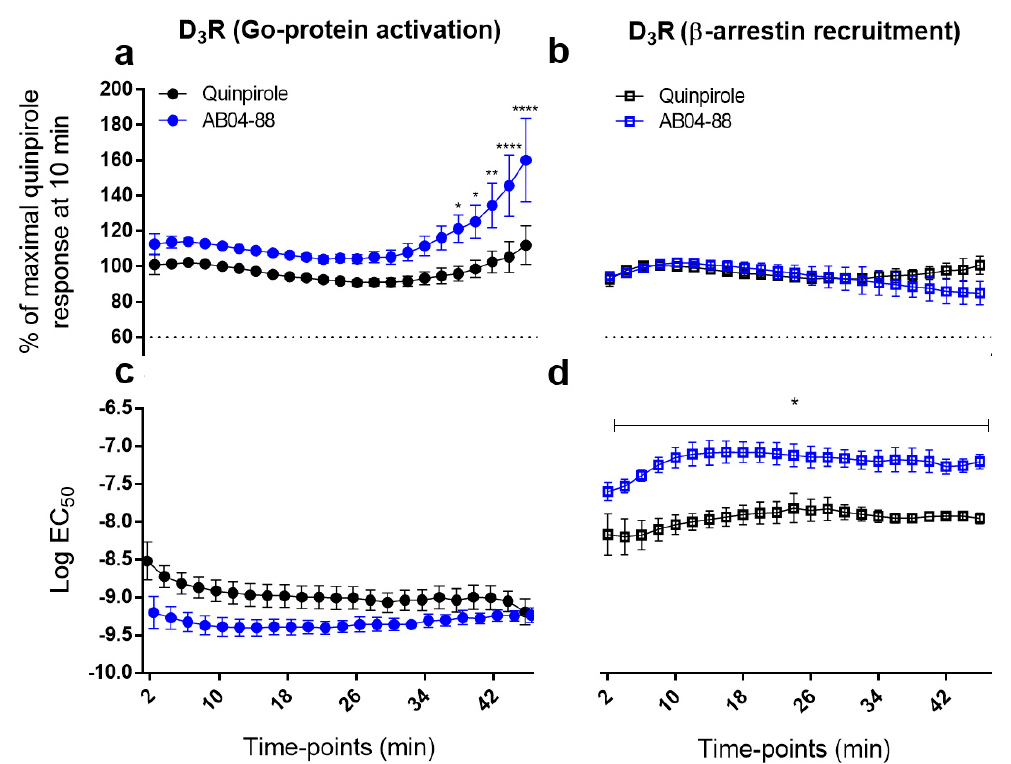
Figure 4. Time-dependent pharmacological profiles of AB04-88 and quinpirole on D 3 R mediated G protein activation and β -arrestin recruitment. a-c. Efficacy ( a , b ) and potency ( c , d ) profiles of D 3 R mediated G protein activation ( a , c ) and β -arrestin recruitment ( b , d ) measured with 2 min interval from 2 to 46 min. The E max values are plotted as percentage of maximal response by quinpirole at 10 min. Plots are presented as means ± SEM of n ≥ 3 independent experiments. Statistical significances were calculated using GraphPad Prism’s ordinary two-way ANOVA (in each case, **** p < 0.0001) followed by Sidak’s multiple comparisons tests with ‘*’ representing significance of p < 0.05; ‘**’ of p < 0.01 and ‘****’ of p < 0.0001 compared to that of quinpirole.